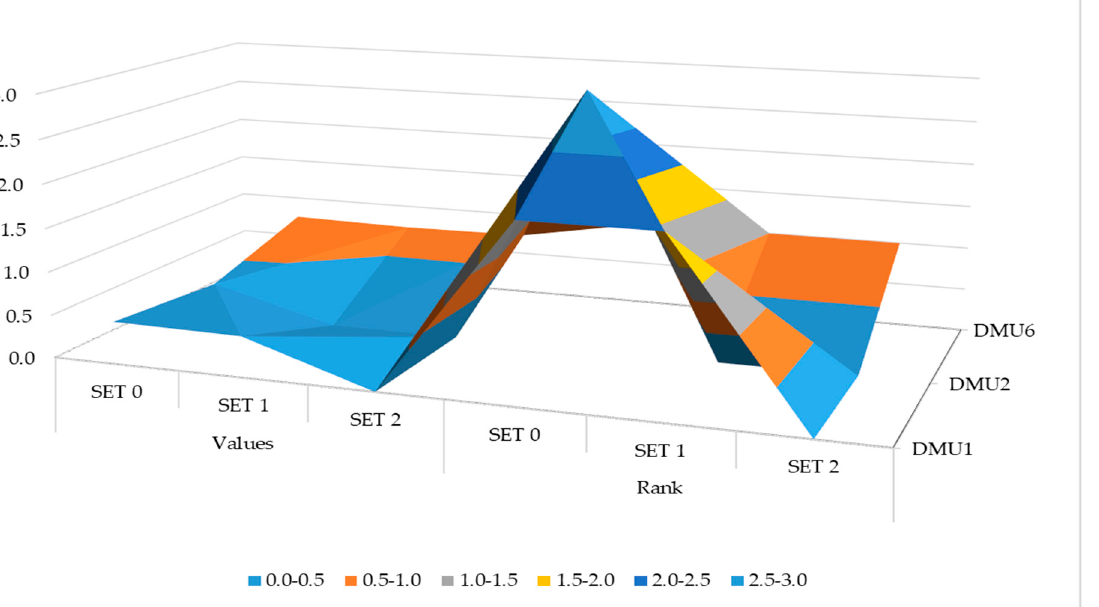
Figure 7. Results after resizing the fuzzy initial